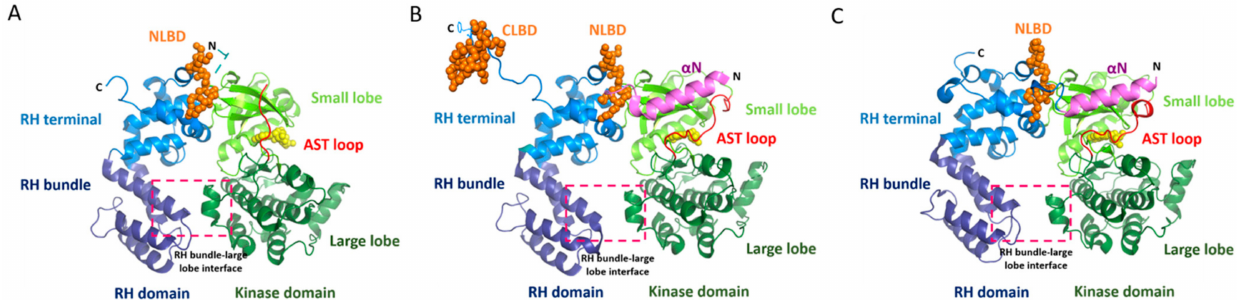
Figure 1. Crystal structures representing inactive and active conformations of the G protein-coupled receptors kinase 4 (GRK4) subfamily members. ( A ) Crystal structure of GRK6 in a complex with adenylyl imidodiphosphate (Protein Data Bank (PDB) entry: 2ACX). ( B ) Crystal structure of GRK6 in a complex with sangivamycin (PDB: 3NYN). ( C ) Crystal structure of GRK5 in complex with Ca 2+ · CaM (PDB: 6PJX), with Ca 2+ · CaM removed for the sake of comparison. The regulator of the G protein signaling homology (RH) and kinase domains are shown in blue and green, respectively. The active site tether (AST) loop and N-terminal ( α N) helix (disordered in panel A ) are highlighted in red and magenta, respectively. The N-terminal lipid-binding domain (NLBD) and C-terminal lipid-binding domain (CLBD) are shown with orange spheres in the structures where they were ordered. The RH bundle–large lobe interface is highlighted with a red dashed box. Ligands bound in the active site are shown with yellow spheres. Note the relative closure of the kinase domain in panels B and C relative to panel A , as well as the ordering of the α N helix and the AST region, which coalesce in the activated